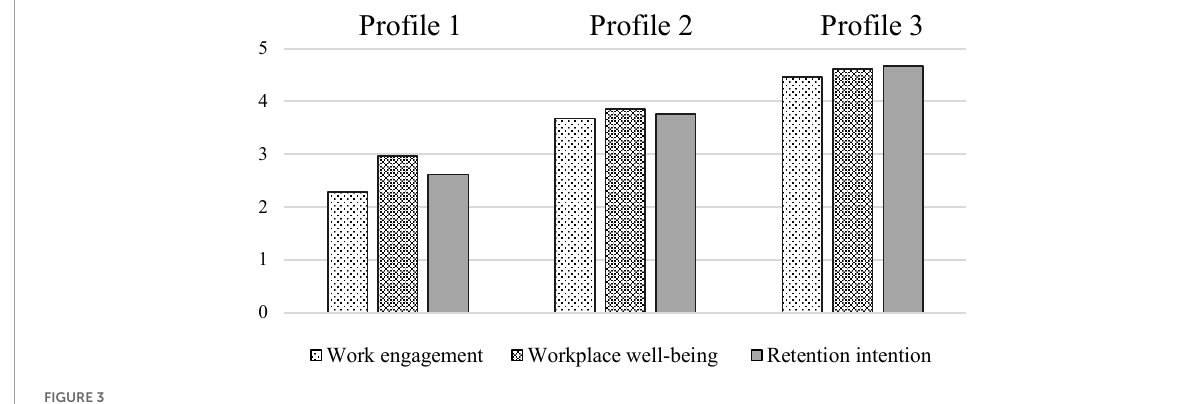
FIGURE3 Outcome levels in the final 3 profile solution.